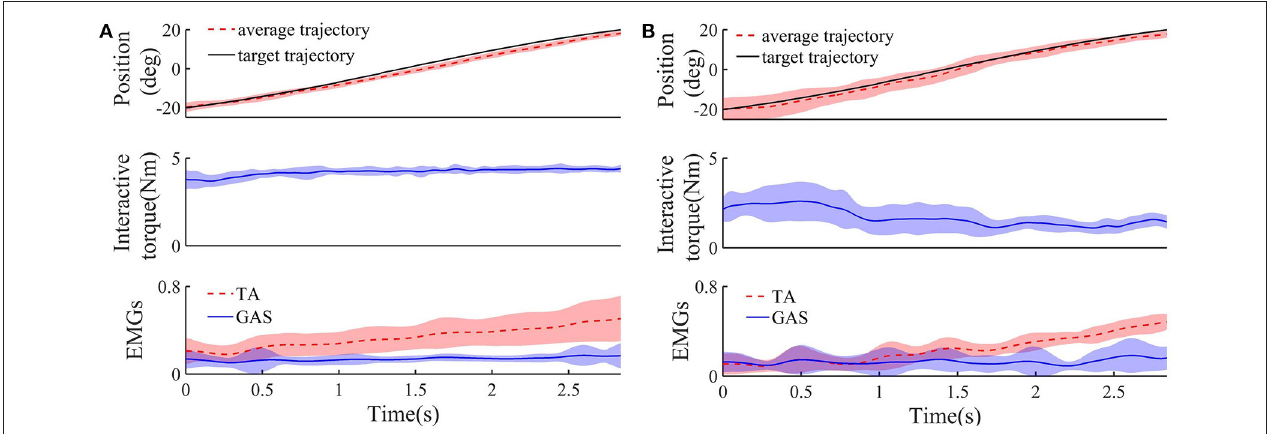
FIGURE 5 | The target, average tracking trajectory, average interaction torque, and average processed EMG signals from TA and GAS of all subject during dorsiflexion phase when robot was controlled by NAACS and K was set at 0 (A) and 0. 5 (B) , respectively ( n standard deviation.